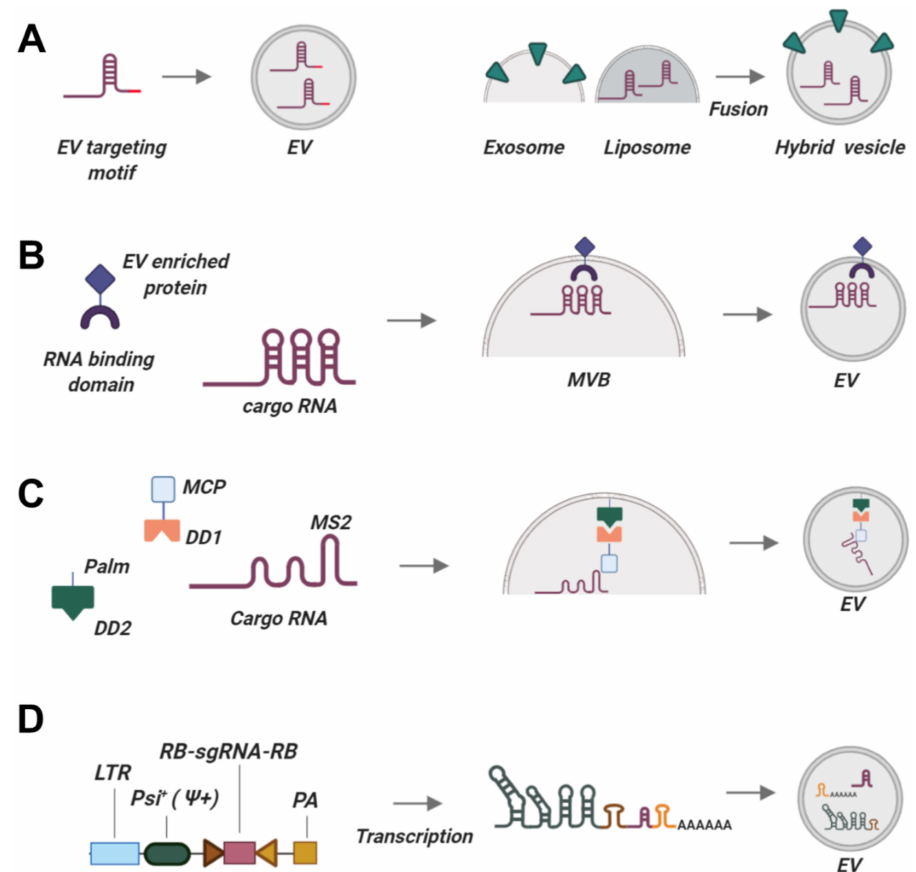
Figure 2. Existing and prospective technologies for tagging sgRNAs to be packaged into EVs. ( A ) Constructing synthetic RNA chimeras with EV-targeting motifs may enrich these RNAs in EVs. ( B ) Using EV-enriched proteins coupled with RNA-binding domains. ( C ) Packaging based on the interaction of MCP protein with an MS2 aptamer introduced into cargo RNA. Palm signal localizes to the membrane of EVs together with dimerization domain DD2. MCP is fused to dimerization domain DD1. Cargo RNA interacts with MCP via MS2 aptamer. Upon incoming signal (light or a small chemical), DD1 and DD2 dimerize, bringing together all three components so that cargo RNA is packaged into EVs. After EVs are produced, DD1 and DD2 dissociate, releasing cargo RNA into the lumina of EVs. ( D ) sgRNA packaging device, a part of the NanoMEDIC platform. A long RNA is encoded intracellularly, comprising the Psi + EV-localization signal and two ribozymes. Upon loading into EVs, the long construct is self-cleaved by ribozymes, releasing the sgRNA with no additional RNA sequences. Abbreviations are explained in the text. This picture was created in